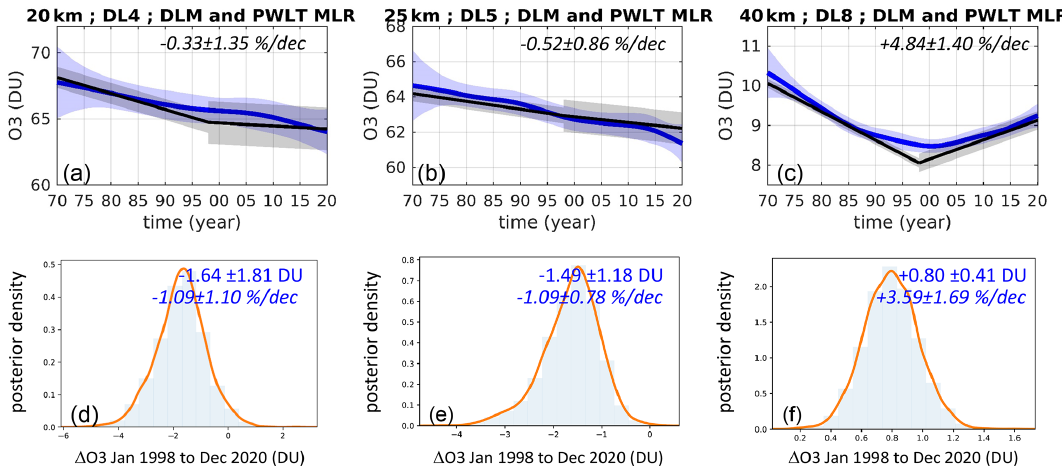
Figure 6. (a–c) DLM (in blue) and MLR (in black) trend estimates in percent per decade ± 2 σ of the Dobson D051 dataset for three DLs between 20 and 40km. The shaded areas show the 2 σ uncertainties. (d–f) The distribution of the DLM trend estimates is given by the kernel density estimation (KDE) for the same three DLs in the 1998–2020 time range in Dobson units ±